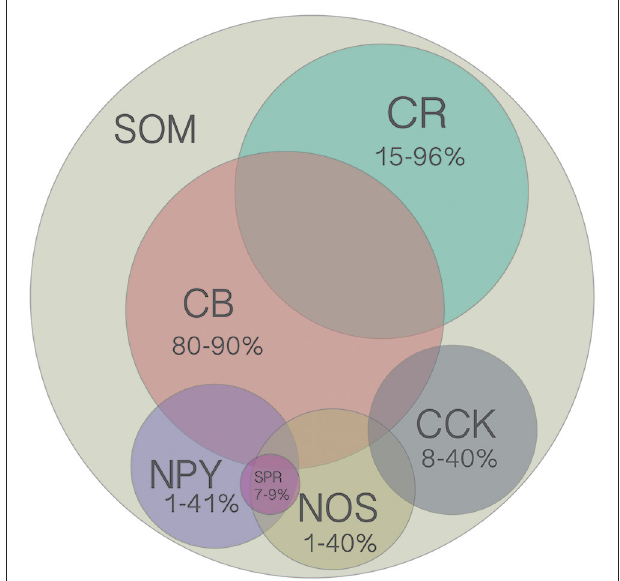
FIGURE 2 | Venn diagram of all molecular markers that are colocalized with SOM (CB, CR, NPY, NOS, CCK). Numbers indicate the range of reported percentages of SOM-positive cells that coexpress a given marker across studies in different species (mouse or rat), cortical layer (2–6), and cortical region (frontal, visual, or somatosensory). For more details, see Table 2 . Area of each circle approximately represents the average range. Overlap of circles indicates known coexpression of depicted markers, however the area of the overlap does not indicate the extent of coexpression. Although there are no reports of SOM cells coexpressing more than two other molecular markers, this possibility has not been ruled out since it was rarely tested